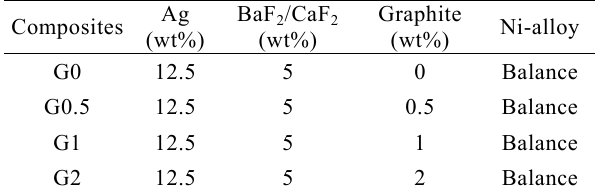
Fig. 1 Schematic diagram of the material preparation process. Table 1 Composition constitutes of the